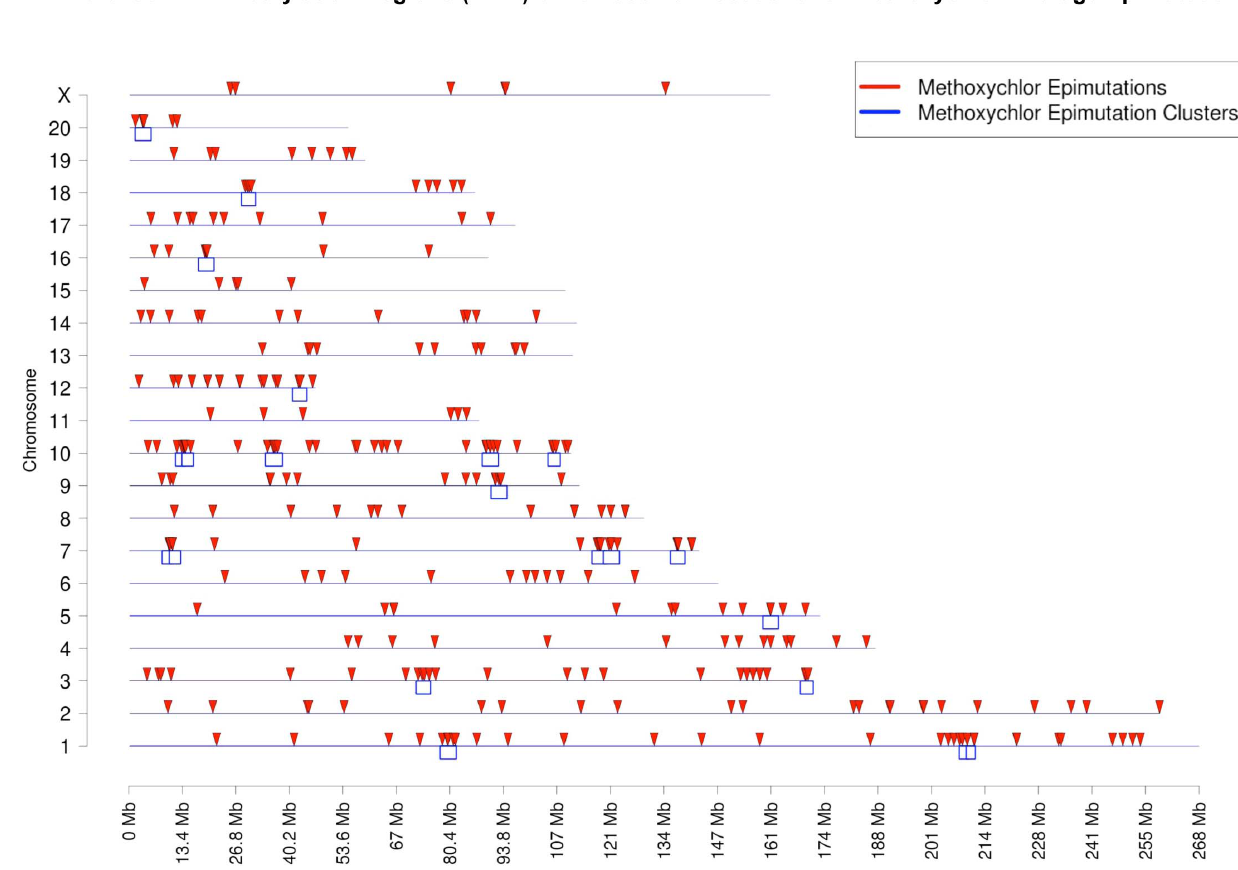
Figure 8. Ancestral exposure to methoxychlor and transgenerational epigenetic changes and induced sperm average epimutations. Chromosomal locations for regions with transgenerational change in DNA methylation (arrowheads). There were 311 differentially methylated regions in sperm DNA from methoxychlor lineage rats compared to control lineage rats for all experiments. The box under the line at each chromosome represents a statistically significant over-representation (cluster) of epimutations.